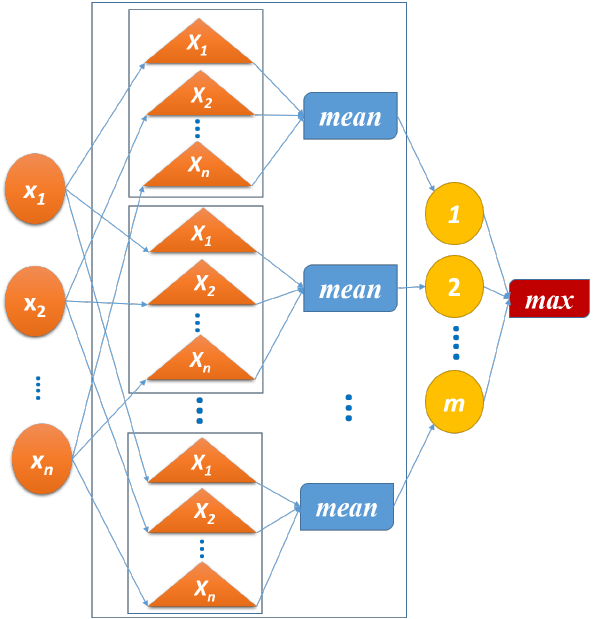
Figure 3. The FNGLVQ architecture